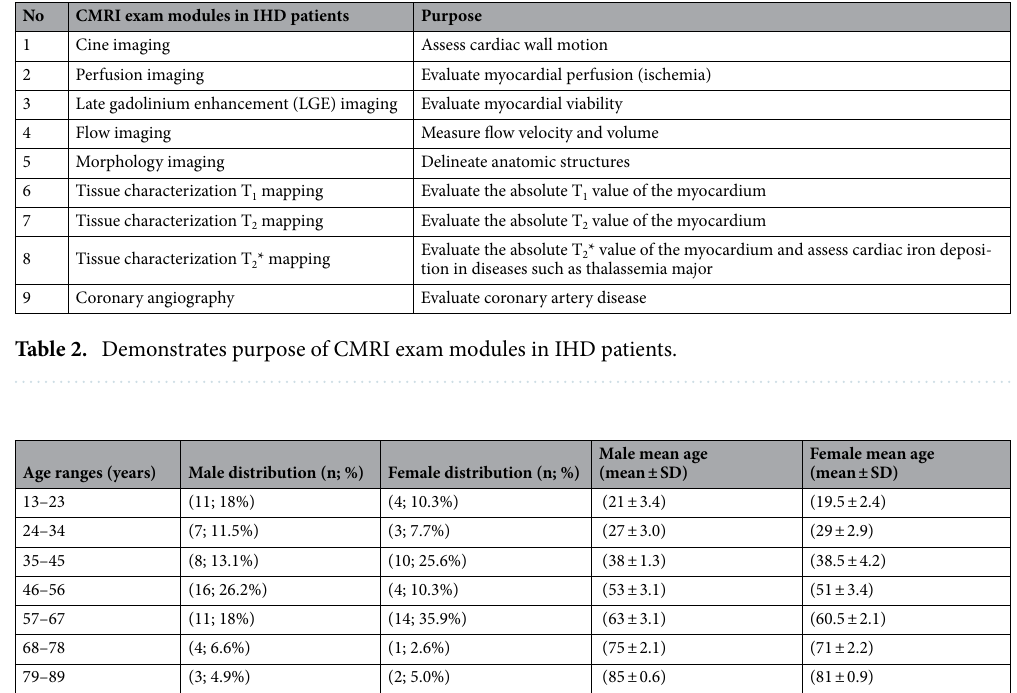
Table 3. Age range (years), age distribution (n; %), and mean age (mean ± SD) in the IHD patients.